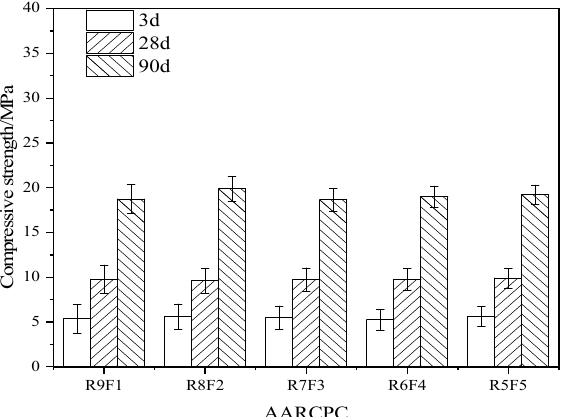
Figure 3. Compressive strength of AARCPC with different fly ash content.